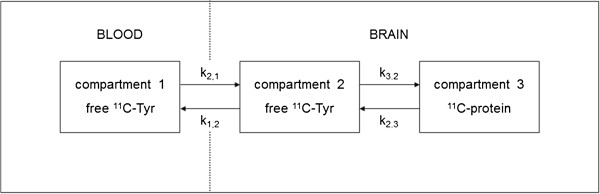
Three-compartment model of 11C fluxes, adapted from Willemsen et al. (1995). Each rate constant kA,B reflects the unidirectional 11C transport to compartment A from compartment B. Compartment 1: blood free 11C-Tyr; compartment 2: brain free 11C-Tyr; compartment 3: brain 11C-protein, i.e. 11C-Tyr incorporated into cerebral protein.